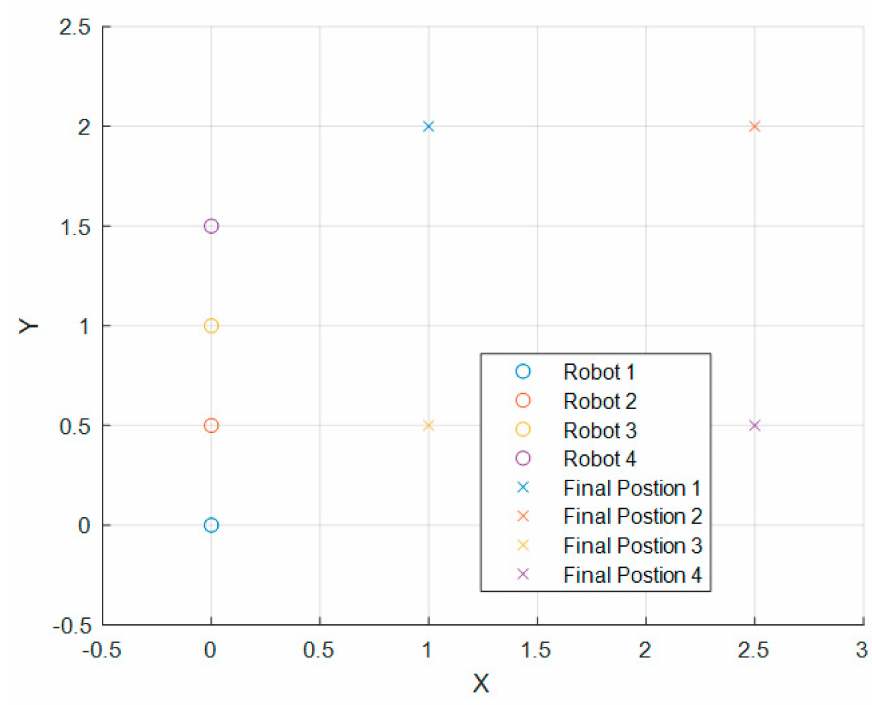
Figure 3. Initial positions of the 4-robot experiment and the desired objective for each robot.